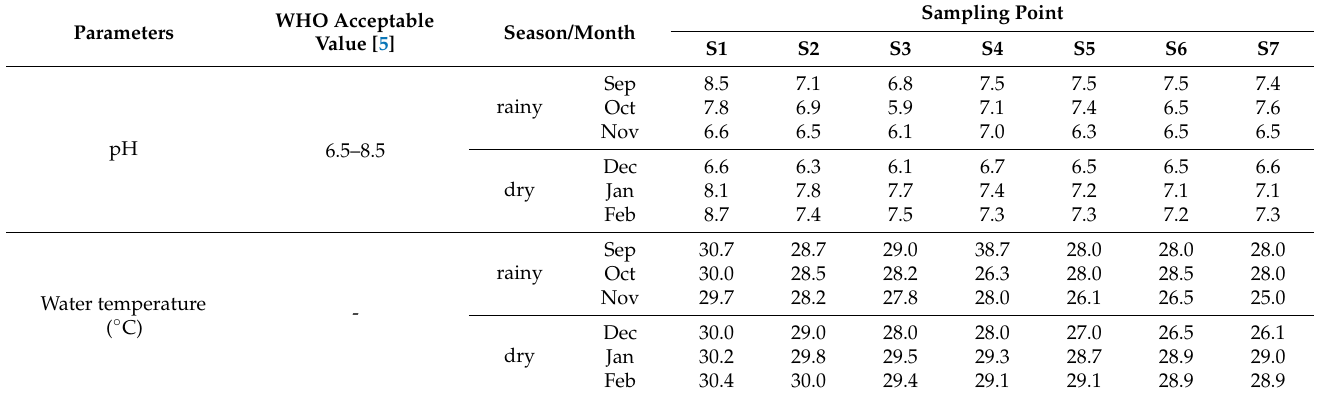
Table 2. Water temperature, conductivity, and pH of water